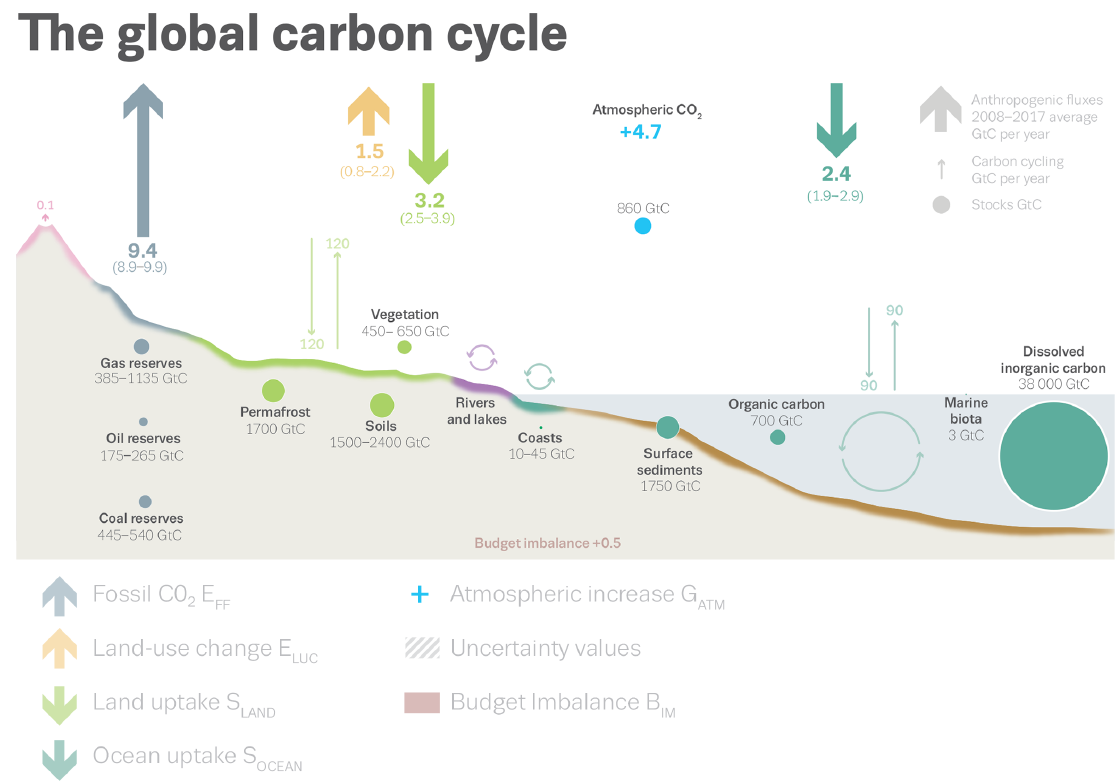
Figure 2. Schematic representation of the overall perturbation of the global carbon cycle caused by anthropogenic activities, averaged globally for the decade 2008–2017. See legends for the corresponding arrows and units. The uncertainty in the atmospheric CO 2 growth rate is very small ( ± 0 . 02GtCyr − 1 ) and is neglected for the figure. The anthropogenic perturbation occurs on top of an active carbon cycle, with fluxes and stocks represented in the background and taken from Ciais et al. (2013) for all numbers, with the ocean fluxes updated to 90GtCyr − 1 to account for the increase in atmospheric CO 2 since publication, and except for the carbon stocks at the coasts, which are from a literature review of coastal marine sediments (Price and Warren,